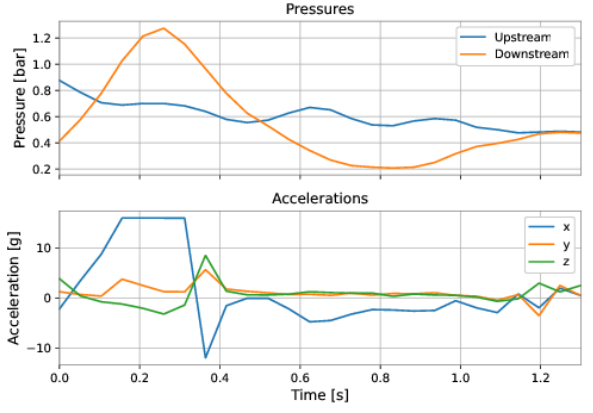
Figure 39. Examples of samples that did not belong to the interest’s regions for the model’s training and, hence, were discarded from the dataset. PIG’s collision at the end of the pipeline.